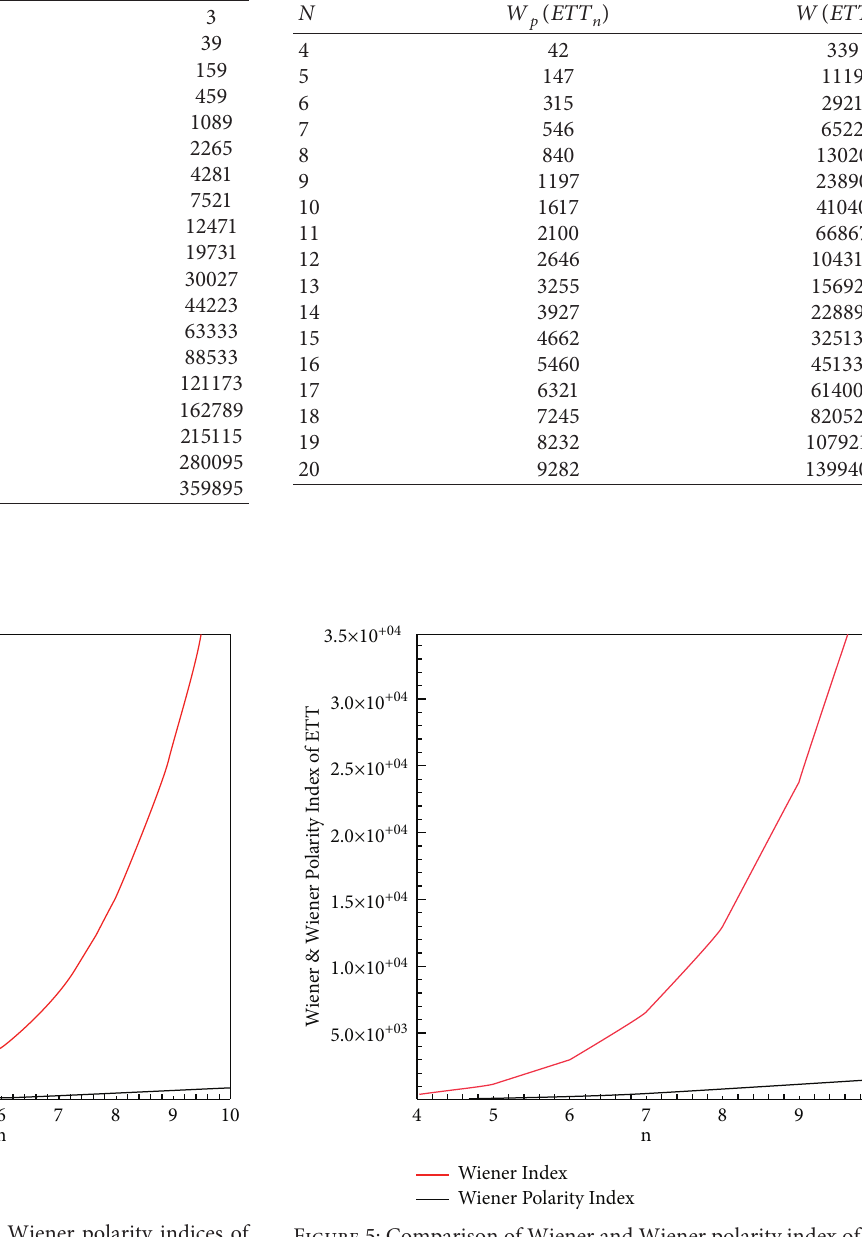
Figure 5: Comparison of Wiener and Wiener polarity index of the equilateral triangular tetra